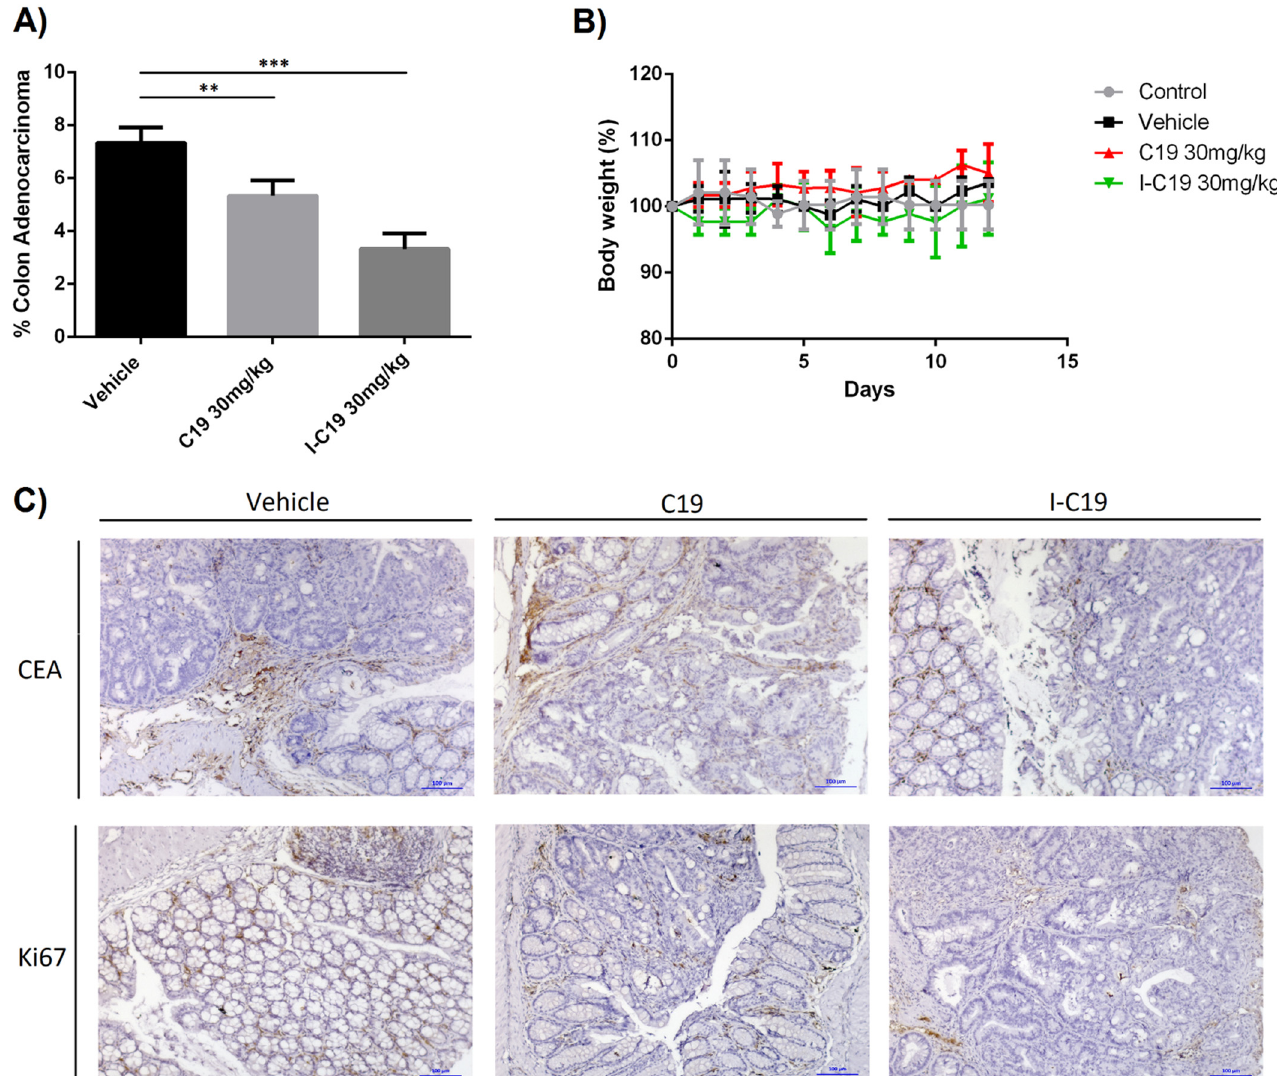
Figure 7. ( A ) The effect of I-C19 treatment on tumor growth of AOM/DSS-treated mice, showing the percentage of colon adenocarcinoma among the mice. The mice were given C19 (30 mg/kg) or I-C19 (30 mg/kg) intraperitoneally every day for 12 days. ( B ) Body weight percentage of AOM/DSS-treated mice, measured every day during treatment. ( C ) Representative pictures of IHC staining for CEA and Ki67 in colorectal tissues. Data are presented as the mean ± SEM from independent experiments ** p < 0.01, *** p < 0.001.